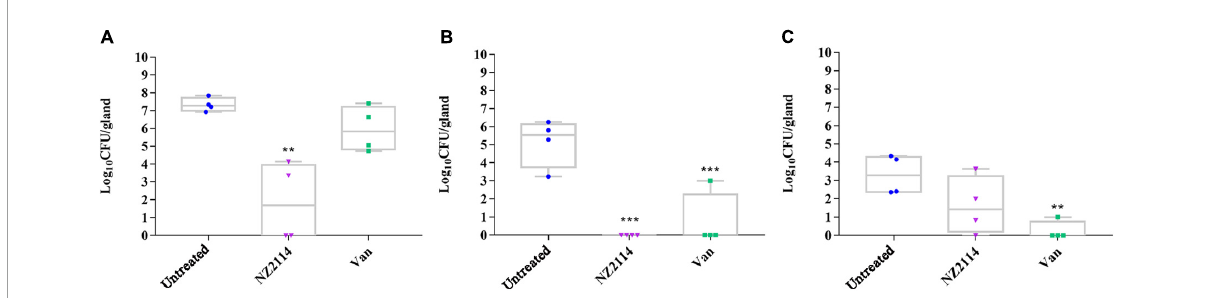
FIGURE5 Effects of NZ2114 on bacterial loads in mammary tissue of S. dysgalactiae infected mice . (A) Treatment for 24 h; (B) treatment for 3 day; (C) treatment for 7 day. A probability value of < 0.05 was considered significant. (*) Indicates the significance between untreated and each of treatment groups. ** p < 0.01; *** p < 0.001. The results are given as the means ± SDs ( n =